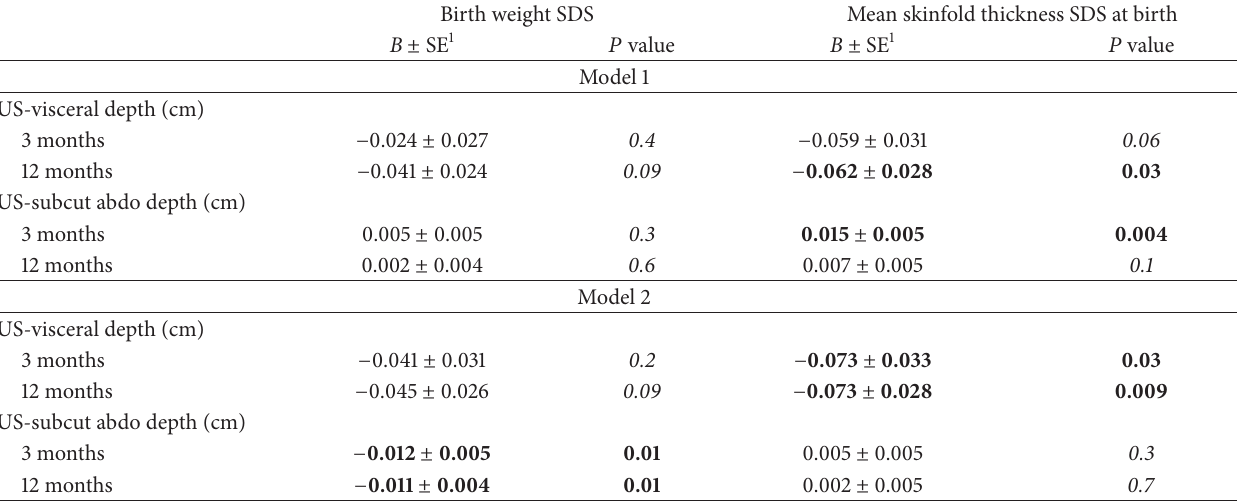
Table 6: Associations between size at birth and ultrasound abdominal depth measurements at 3 months (487 infants) and 12 months (495